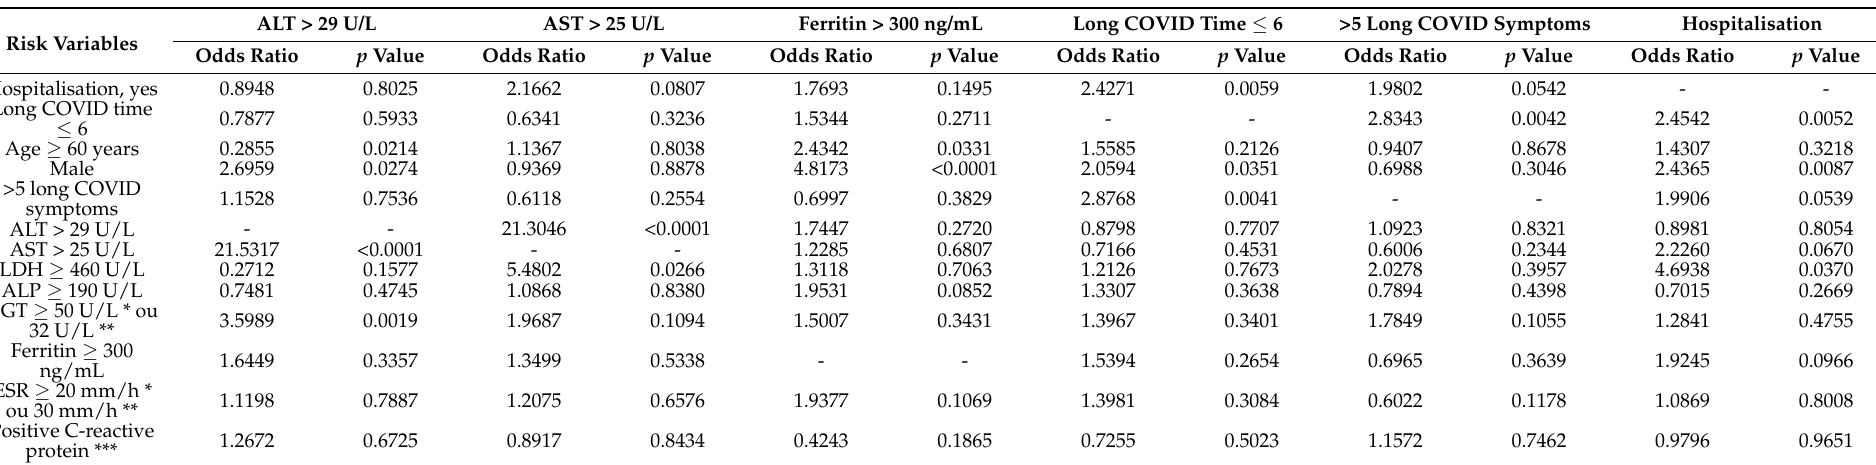
Table 4. Factors associated with changes in liver injury markers, post-COVID time, symptoms, and hospitalisation in study patients. Bel é m/PA,